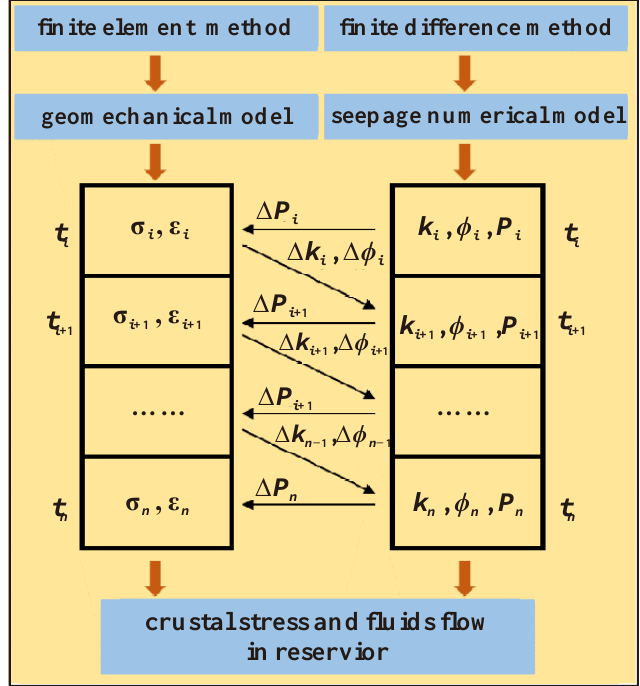
Figure 5. Seepage-geomechanics iterative coupling process.